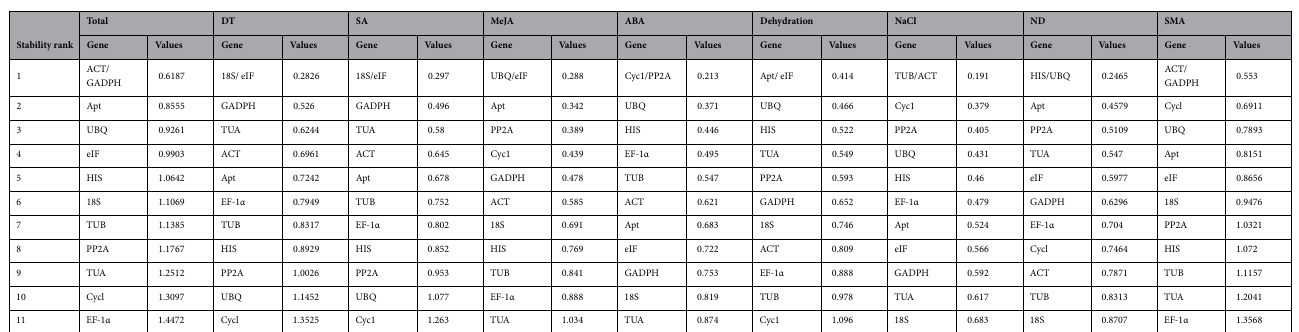
Table 2. Expression stability M-value of 12 candidate reference genes calculated by